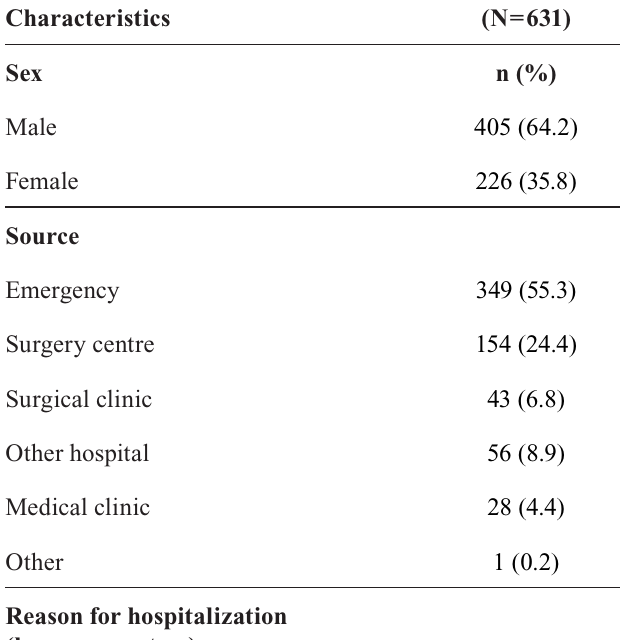
Table I - D emographic characteristics of the study population